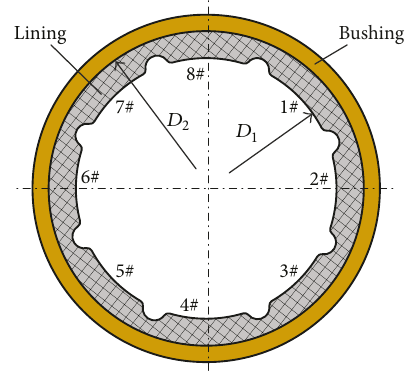
Figure 3: Schematic diagram of rubber bearings.